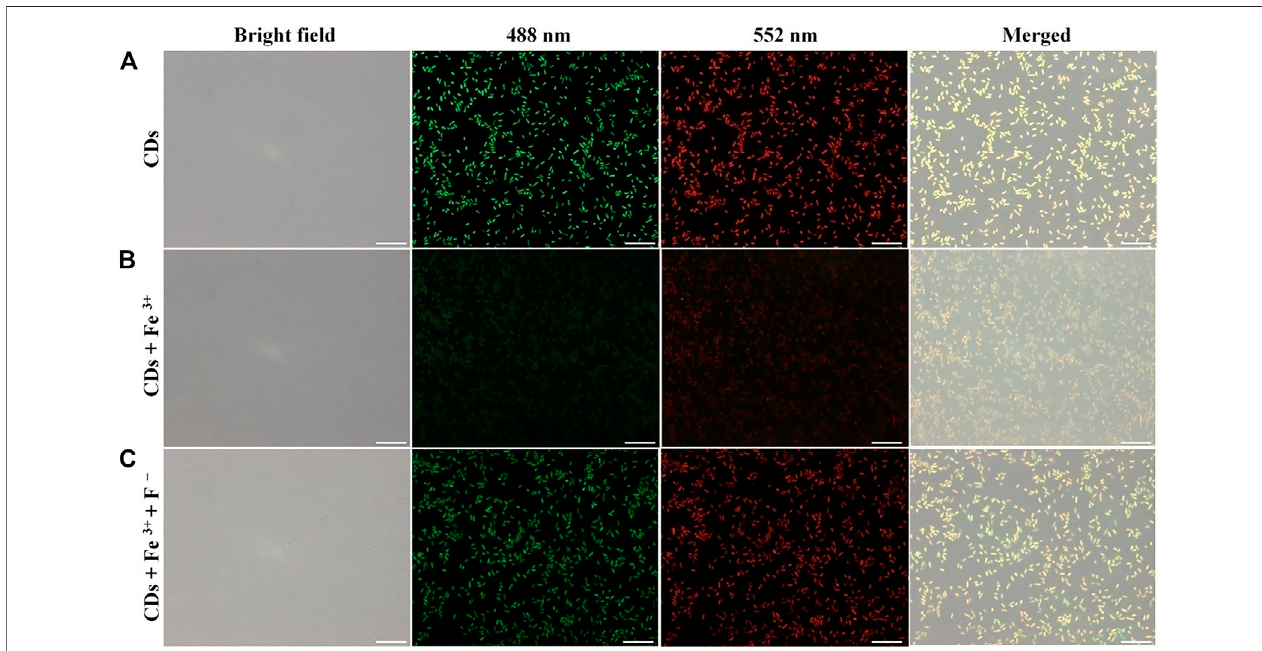
FIGURE 7 | Bright- fi eld, fl uorescence, and the overlaid images of E. coli . E. coli was incubated with N/P CDs (A) ; E. coli was incubated with N/P CDs and then treated with Fe 3+ (B) ; E. coli was incubated with N/P CDs, Fe 3+ , and then treated with F − (C) . Images were captured with 488 (green) and 552 nm laser (red). The scale bars represented 10 μ